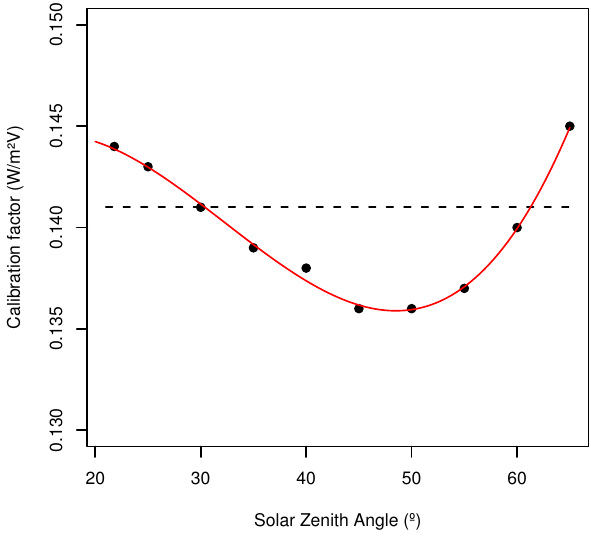
Fig. 1. Dependence of the calibration factors provided by the manu- facturer (in black) on the solar zenith angles below 65 ◦ . The red line corresponds to the polynomial function given by the expression 1. The dashed line represents the fixed value of 0.141Wm − 2 V − 1 proposed by the manufacturer when the dependence on solar zenith angle is not